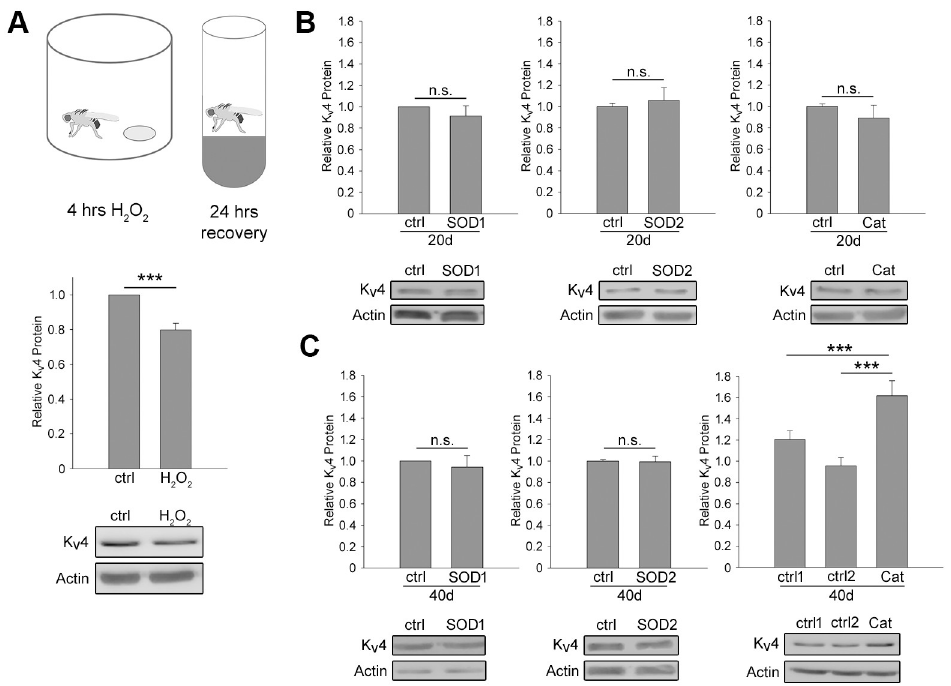
Fig 3. K v 4/Shal protein levels reduced by ROS and ameliorated by over-expression of catalase in older flies. (A) Acute exposure to hydrogen peroxide (H 2 O 2 ) leads to decreased K v 4/Shal protein levels. Top , cartoon depicting incubation of Drosophila in a closed scintillation vial with a paper filter containing 100 μ L H 2 O 2 , followed by recovery in regular food vial at room temperature. Bottom , Representative immunoblots and quantitative analyses of K v 4/Shal protein levels, normalized to an anti-Actin loading control, in wild-type flies incubated with either water (ctrl) or H 2 O 2 for 4 hours followed by 24 hours recovery (N = 15). (B-C) Representative immunoblots and quantitative analyses of relative K v 4/Shal protein levels, normalized to an anti-Actin loading control, in heads from UAS-SOD1 ( Left , ctrl), elav- GAL4 >> UAS-SOD1 ( Left , SOD1), UAS-SOD2 ( Middle , ctrl), elav-GAL4 >> UAS-SOD2 ( Middle , SOD2), UAS-Catalase ( Right , ctrl), elav-GAL4 >> UAS-Catalase ( Right , Cat) flies aged at 25˚C for either 20 days (B) or 40